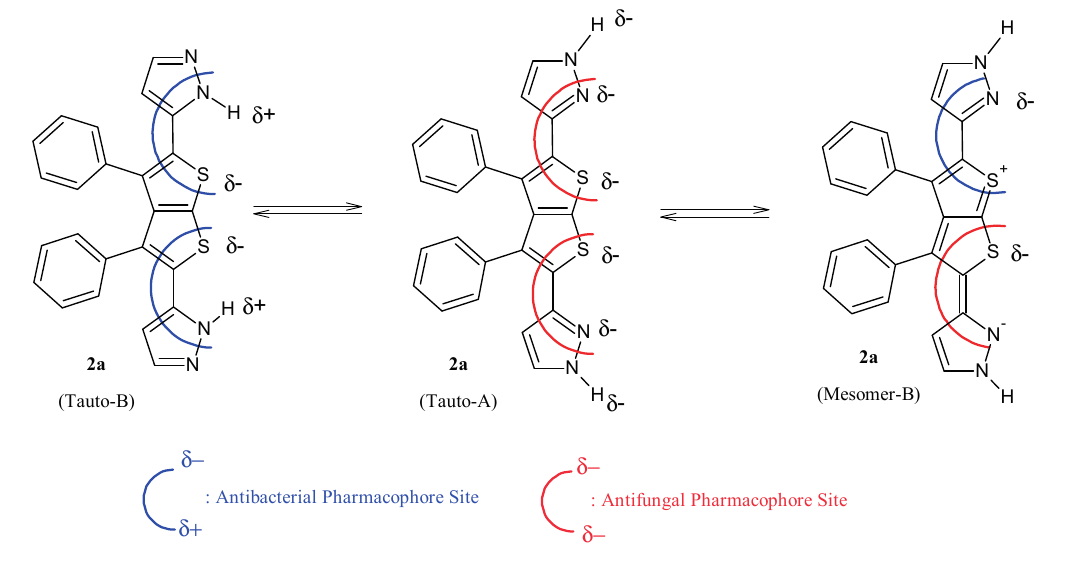
Figure 3. Identification of explicit and combined antibacterial/antifungal pharmacophoric sites of compound 2a .